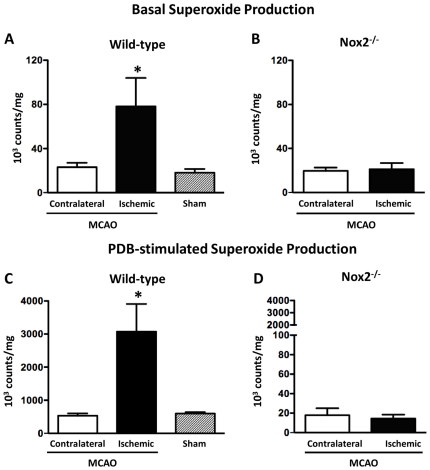
Effect of cerebral ischemia-reperfusion on vascular superoxide production.Basal (A and B) and phorbol-12, 13-dibutyrate (10 µmol/L; PDB: Nox2 activator)-stimulated (C and D) superoxide production by middle cerebral arteries (MCA) as measured by 100 µmol/L L-012-enhanced chemiluminescence. A. Contralateral and ischemic MCA from wild-type mice 24 h after MCA occlusion, and pooled left and right MCA from sham-operated wild-type mice. B. Contralateral and ischemic MCA from Nox2-deficient (Nox2-/-) mice 24 h after MCAO. C. Contralateral and ischemic MCA from wild-type mice 24 h after MCA occlusion (MCAO), and pooled left and right MCA from sham operated wild-type mice. D. Contralateral and ischemic MCA from Nox2-/- 24 h after MCAO. All results are expressed as 103 counts/mg of dry tissue weight and given as mean±SEM (A and C, n = 9 for both groups of MCAO; n = 7 for sham; B and D, n = 6 for both groups). *P<0.05 vs. contralateral MCA (one way ANOVA with a Bonferroni mutiple comparison post hoc test).